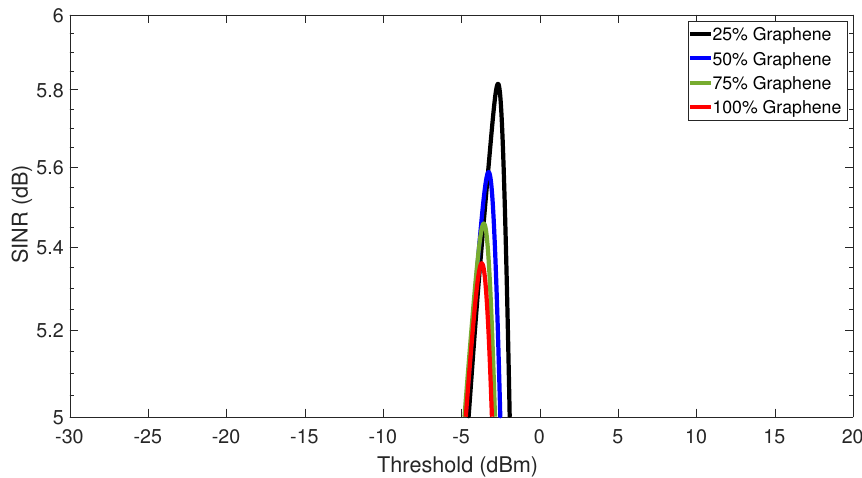
Figure 9. Signal-to-interference-plus-noise-ratio (SINR) versus the optimum threshold.